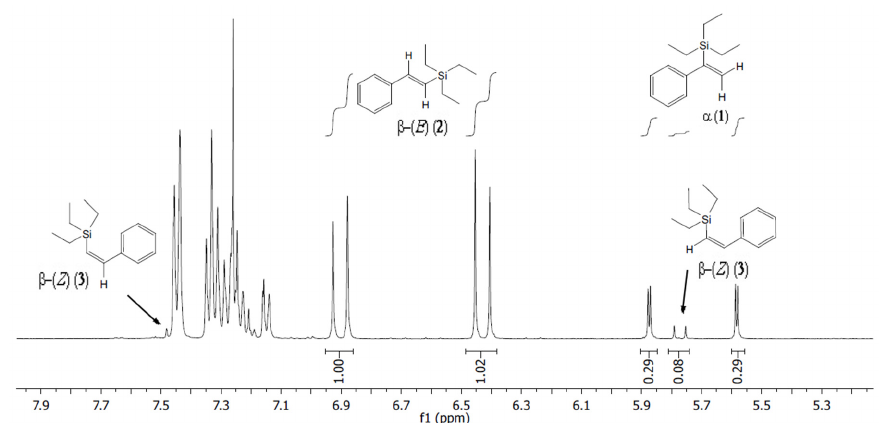
Figure 7. Characteristic 1 H NMR shifts of a mixture of vinyl ‐ silane products 1 – 3 prepared using commercial Pt/Al 2 O 3 (E4759).